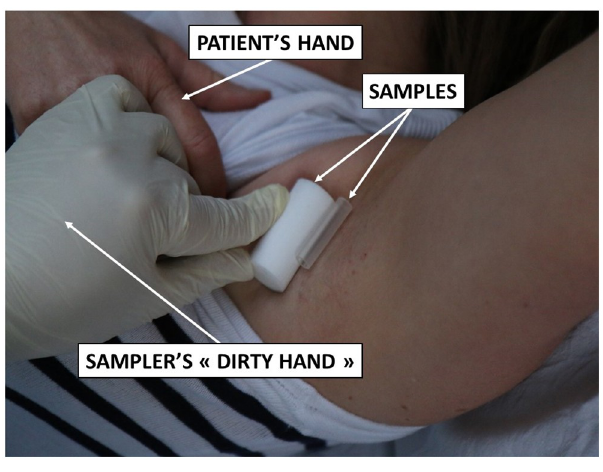
Fig 2. Underarm sampling.